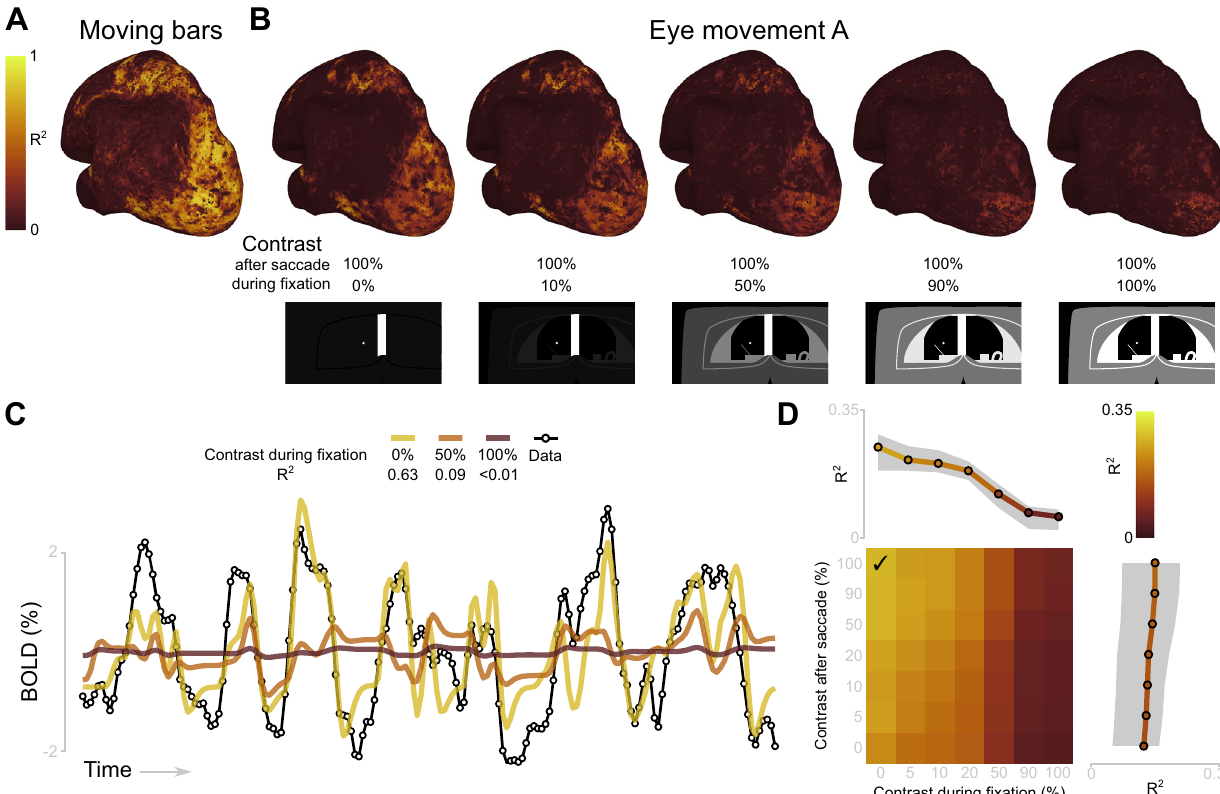
Fig. 2 | Creating the optimal retinotopic representation of the visual input to capture responses in visual cortex during the eye- movement task. A Left hemisphere surface of anexample participant showing the varianceexplained (R 2 ) by the pRFs for the moving bar paradigm — these data were used to estimate the pRFs. B Same example hemisphere as in A, now overlaid with the variance explained for different con fi gurations of the retinotopic representation of the visualinputduringtheeye-movementtask.Inallcon fi gurations,thecontrastofthe peripheral stimuli increased to the same level as the vertical bars after a saccade andwasreducedtoalowercontrastlevelduringperiodsof fi xation(rangingfrom0 to 100%). The different contrast levels of the peripheral elements are displayed at the bottom. The white vertical bar is the high-contrast fl ickering checkboard bar. The point in the center is the fi xation point. C Example BOLD time series from the